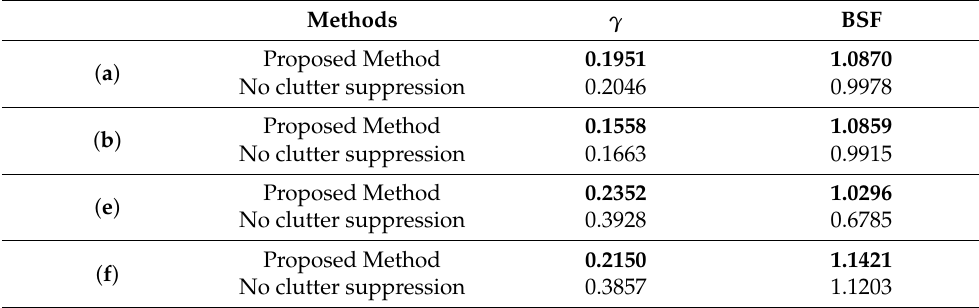
Bold indicates that this metric has better